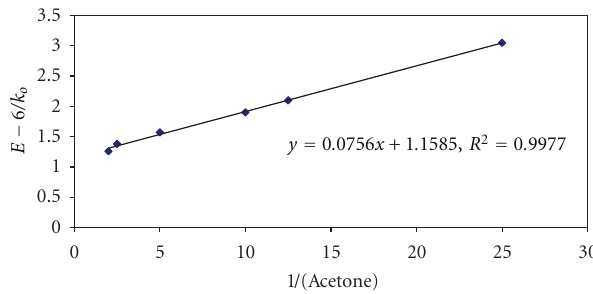
Figure 2: Plot of 1 /k o versus 1/[acetone] in Ru (III) catalyzed NBS-